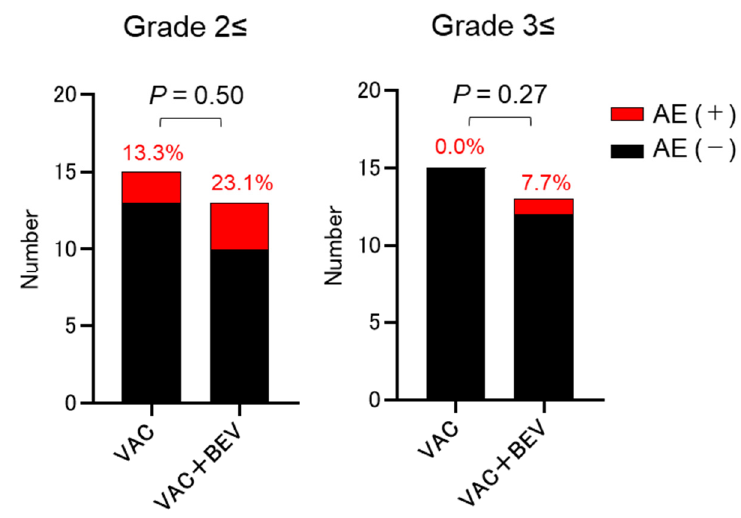
Figure 1. Comparison of the percentage of adverse events in malignant glioma patients treated with